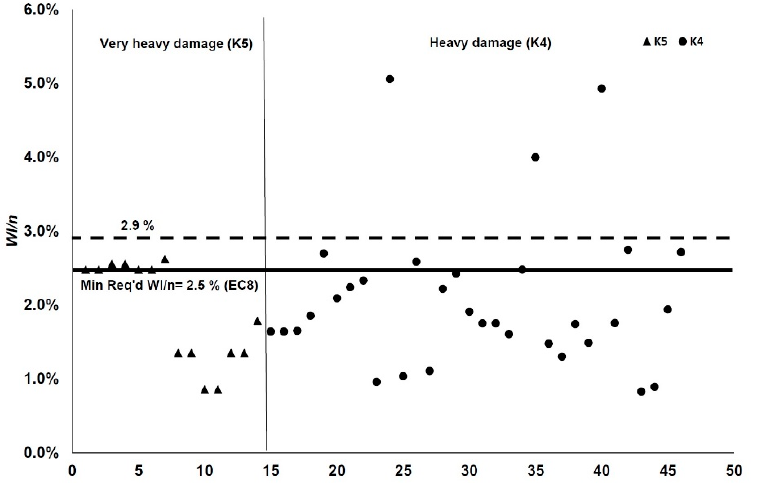
Figure 7. Relationship between the WI/n and damage grade for 23 buildings (based on two WI/n values per building).